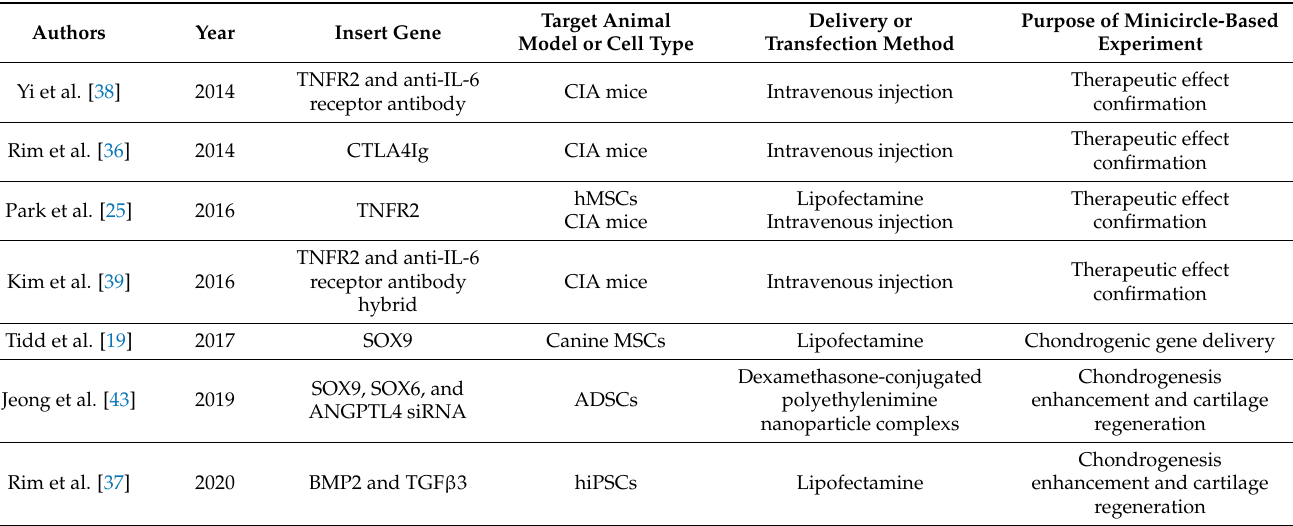
Table 3. List of gene therapy studies on RA and OA using minicircle